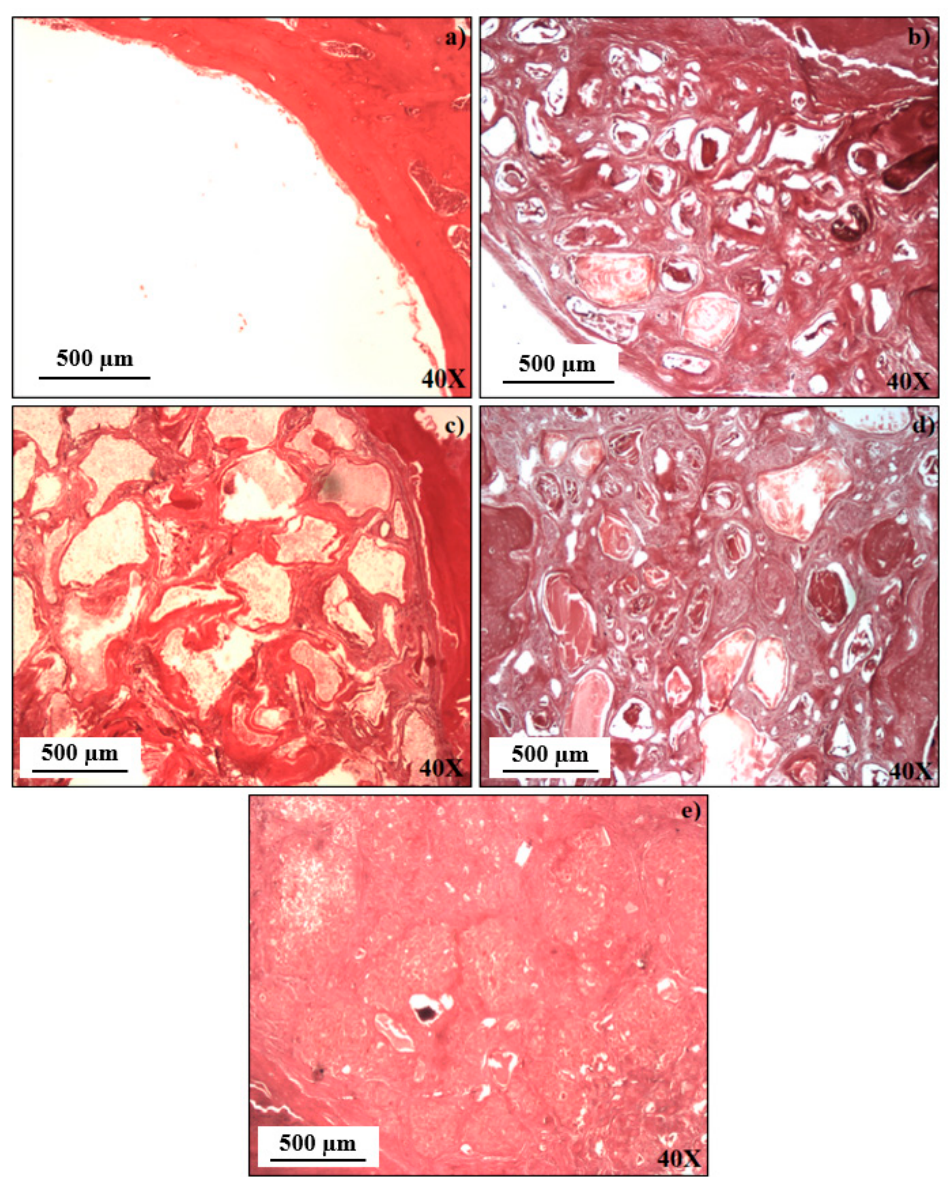
Figure 7. Histological images (VK staining) of bone defects 9 weeks after treatment and after excision: ( a ) empty defect; and defects filled with: ( b ) BG; ( c ) 3TCP0/7BG; ( d ) 3TCP1/7BG; ( e )